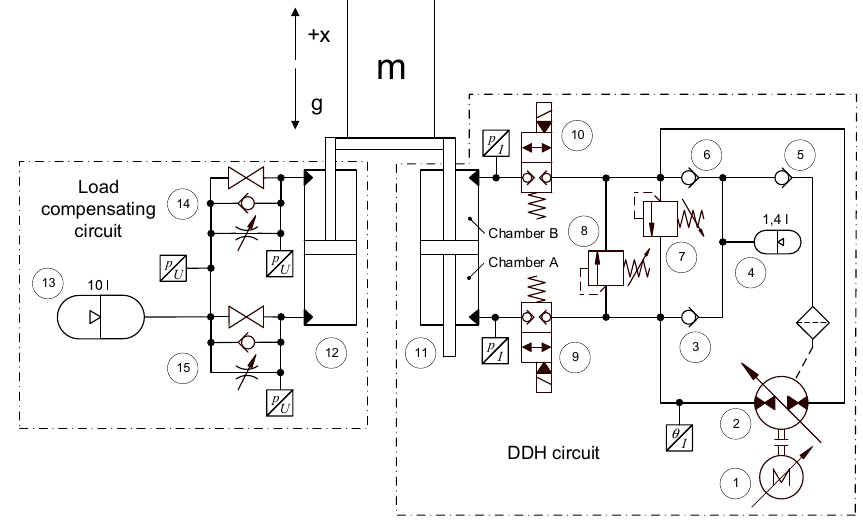
Figure 2. Two separate hydraulic systems of the test rig; actuating DDH circuit (right), and compensation and damping circuit (left).